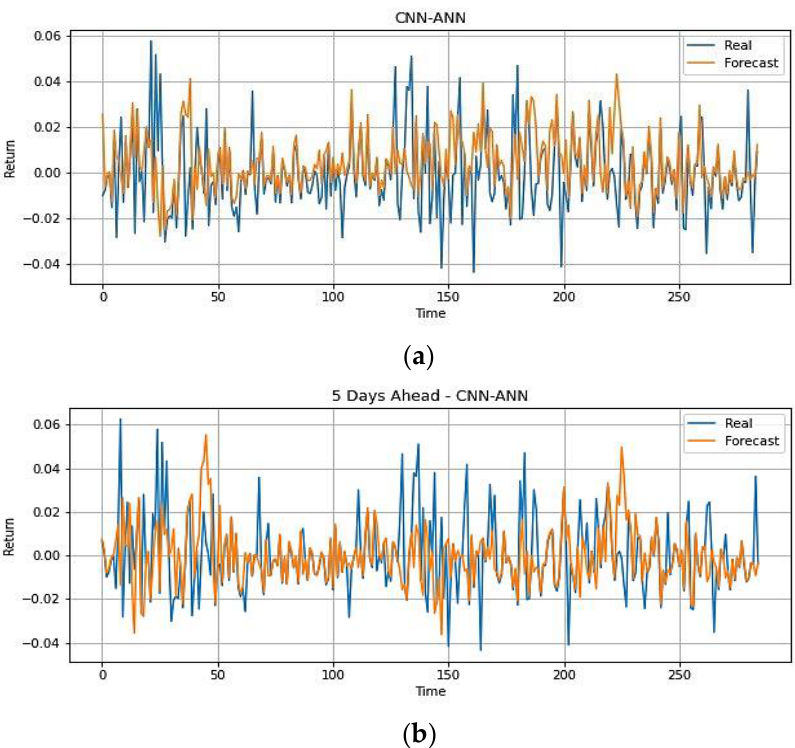
Figure 9. CNN-ANN Forecasting Result for One-Day- ( a ) and Five-Day-Ahead ( b ).